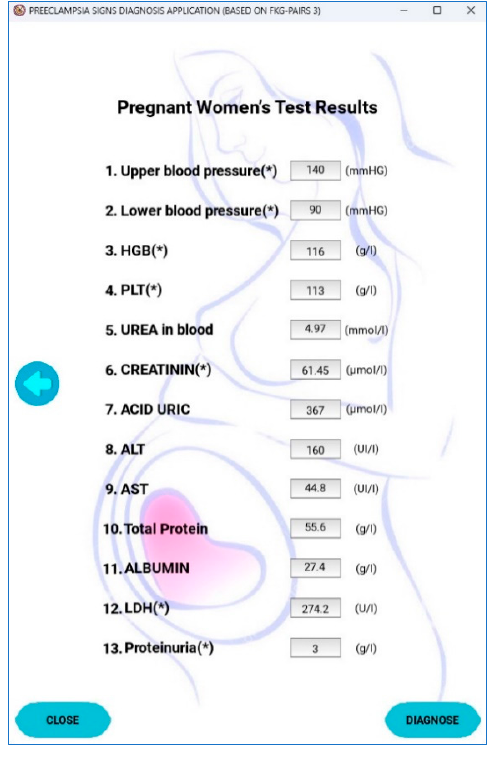
Figure 7. Screen for entering subclinical test results.